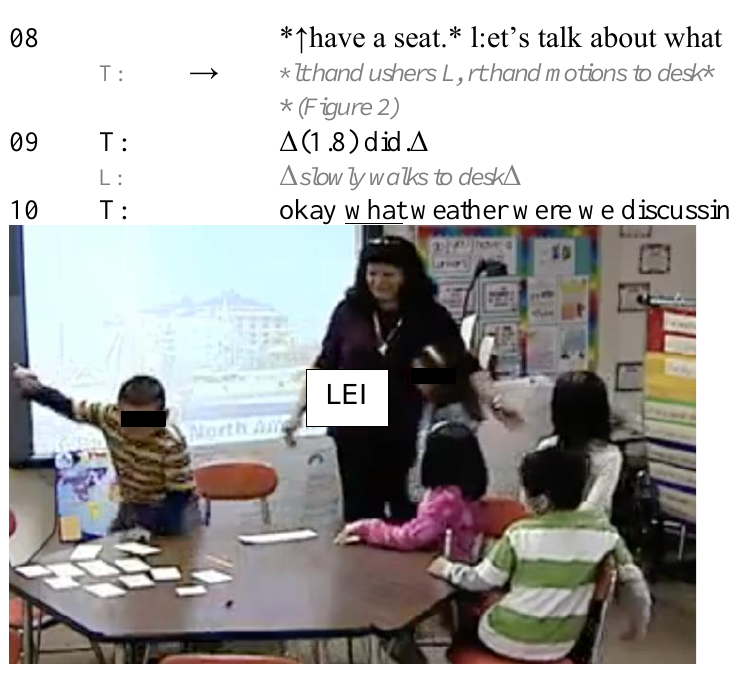
Teacher motions with right hand toward desk and ushers Leila with left